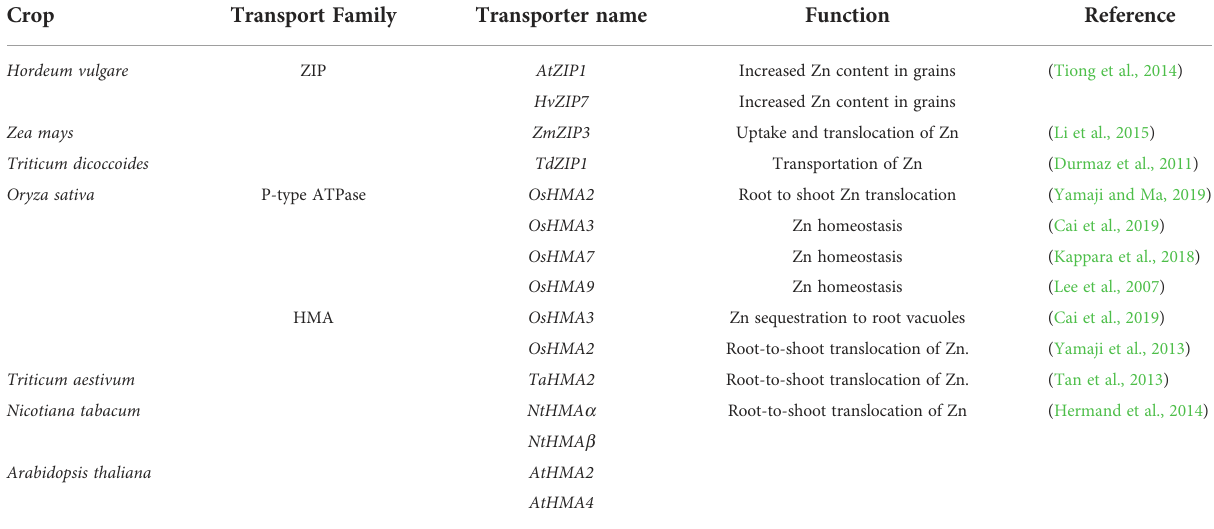
TABLE 2 Functions of zinc transporters-coding genes in